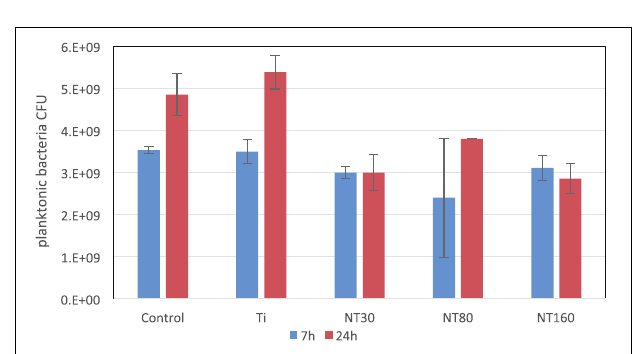
FIGURE 6 | Bacteria number in planktonic form at 7 and 24 h.